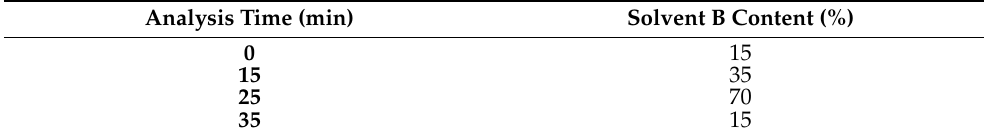
Table A2. Gradient elution conditions.